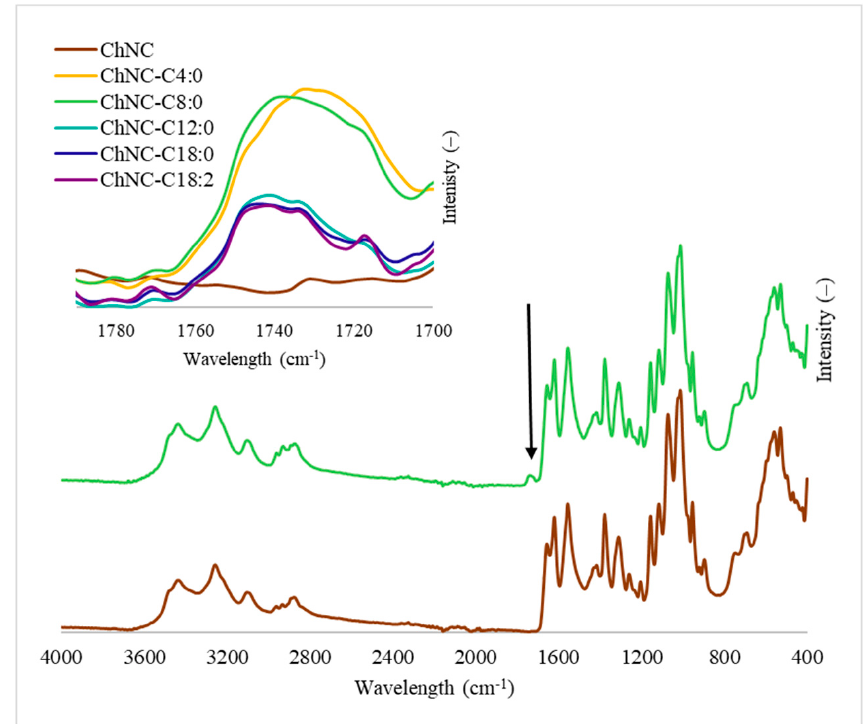
Figure 2. FTIR spectra of unmodified chitin nanocrystals and nanocrystals modified with fatty acids. The presence of the ester group at 1735–1750 cm − 1 is highlighted in the inset; its intensity is dependent on the fatty acid of choice.